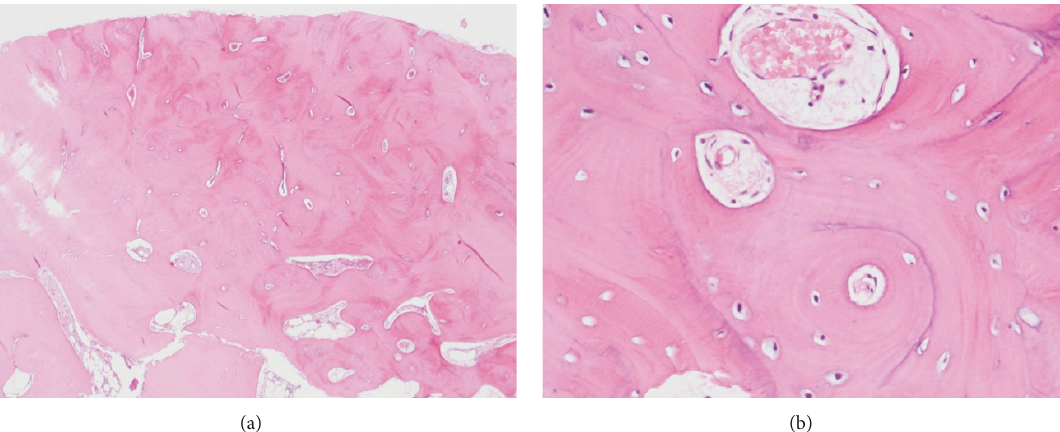
Figure 5: Histopathological findings of the mandible. Enlarged and sclerotic bone trabeculae with little inflammatory cell infiltration [hematoxylin-eosin staining; magnification: 100 × (a), 400 ×